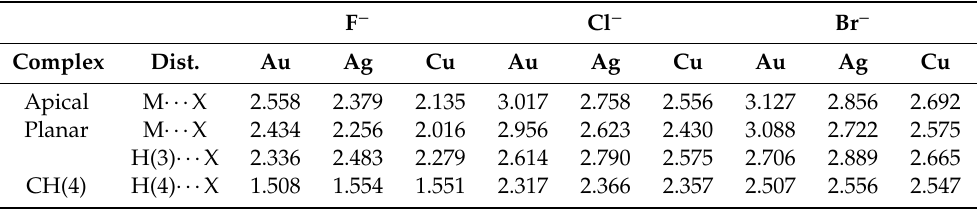
Table 2. Geometrical intermolecular M ··· X − and H ··· X − distances (Å) in the 1:1 complexes. F − Cl − Br − Complex